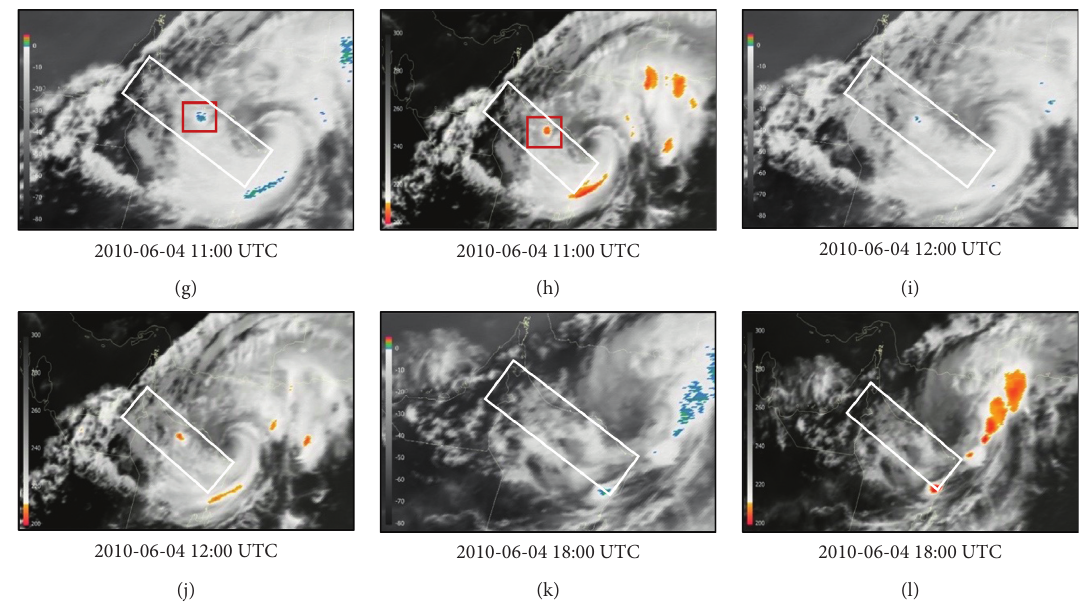
Figure 13: Sequence of BTD (WV6.2 μ m–IR10.8 μ m) (right) and coldest brightness temperature IR10.8 μ m (left) on 3rd and 4th June.